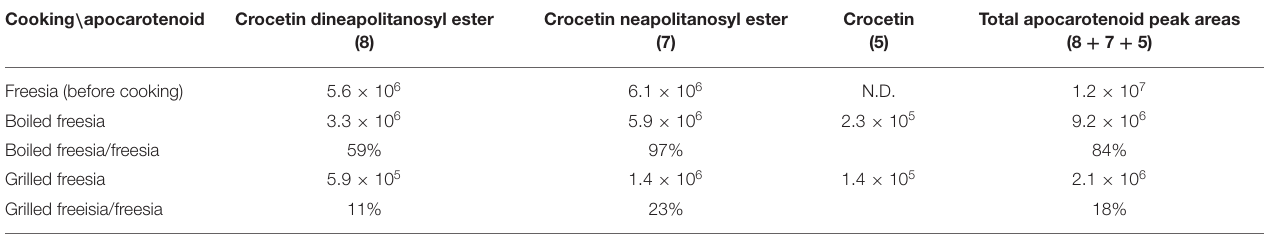
TABLE 2 | HPLC peak areas (mV × s) of apocarotenoids in cooked freesia yellow flowers at 440nm.